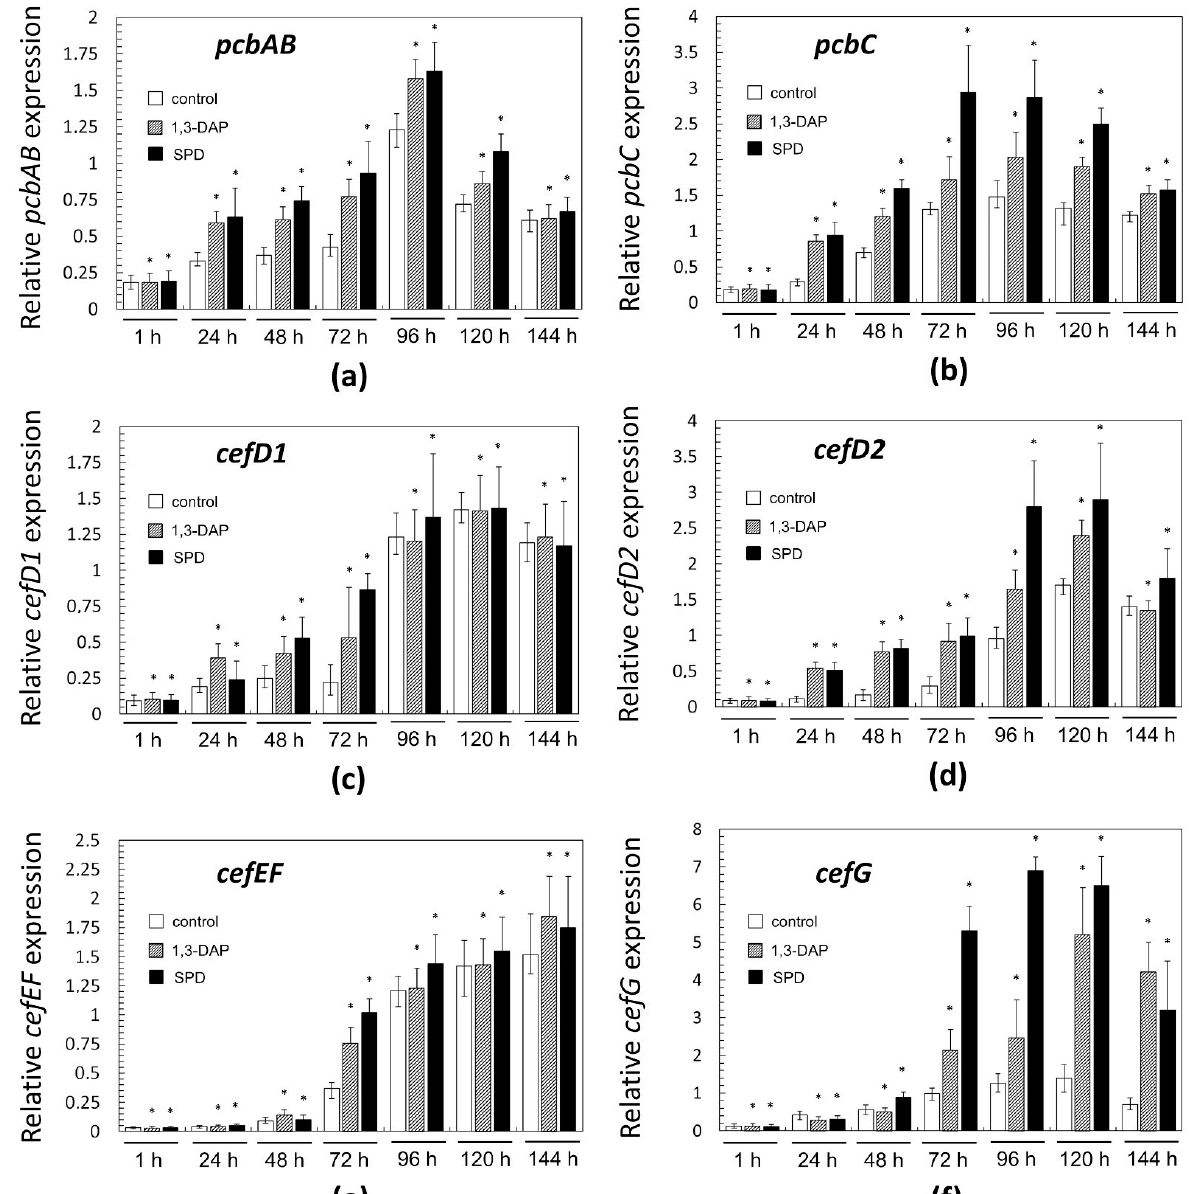
Figure 7. Expression dynamics of: ( a ) pcbAB ; ( b ) pcbC ; ( c ) cefD1 ; ( d ) cefD2 ; ( e ) cefEF ; ( f ) cefG genes in A. chrysogenum HY strain after the addition 5 mM 1,3-DAP or 5 mM spermidine (SPD). After 1, 24, 48, 72, 96, 120, and 144 h of fermentation on complex (CP) medium. Data are means ± SD, n = 3. Statistical significance, * p ≤ 0.05, as compared with the control (strain, cultivated on medium without PAs additions).